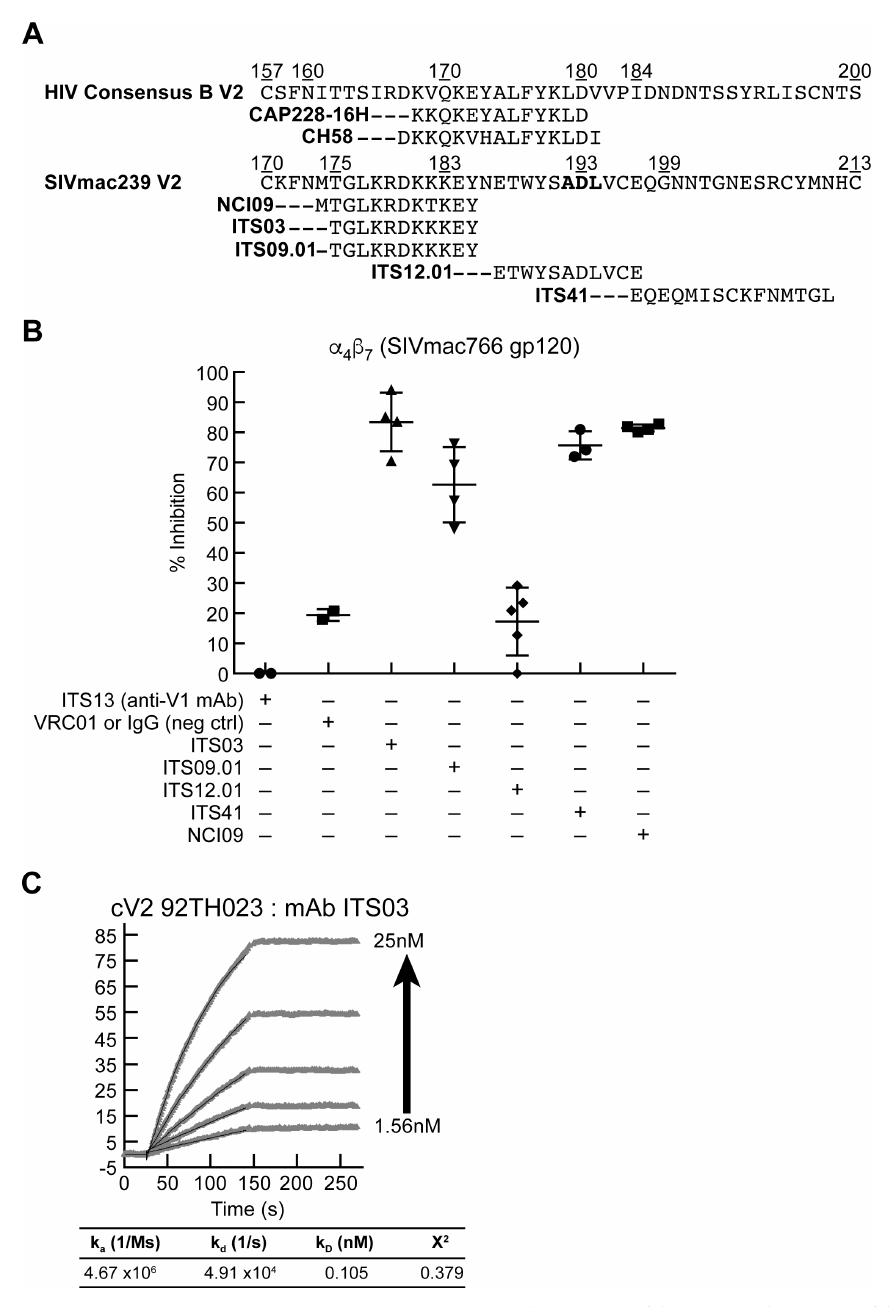
Fig 8. Inhibition of α 4 β 7 adhesion by SIV V2 specific mAbs. A) Alignment of the amino acid sequences of the V2 domains of HIV consensus B and SIVmac239, and the regions of the V2 containing epitopes recognized by V2 specific mAbs. B) Adhesion of RPMI8866 cells to DG SIVmac766 gp120 in the presence of SIV V2-specific mAbs: ITS03, ITS09.01, ITS12.01, ITS41, and NCI09. ITS13, a V1 mAb and VRC01, an HIV gp120 mAb are included as nonspecific mAb controls. Presence of each inhibitor indicated by a + sign below. Y-axis indicates % inhibition relative to adhesion in the absence of any inhibitor in three or more independent experiments. Error bars indicate SD. C) SPR analysis showing increasing concentrations of ITS03 mAb (2-fold increases from 1.56 nM-25 nM) binding to an HIV cV2 92TH023 coated surface. The parameters of binding kinetics are listed.